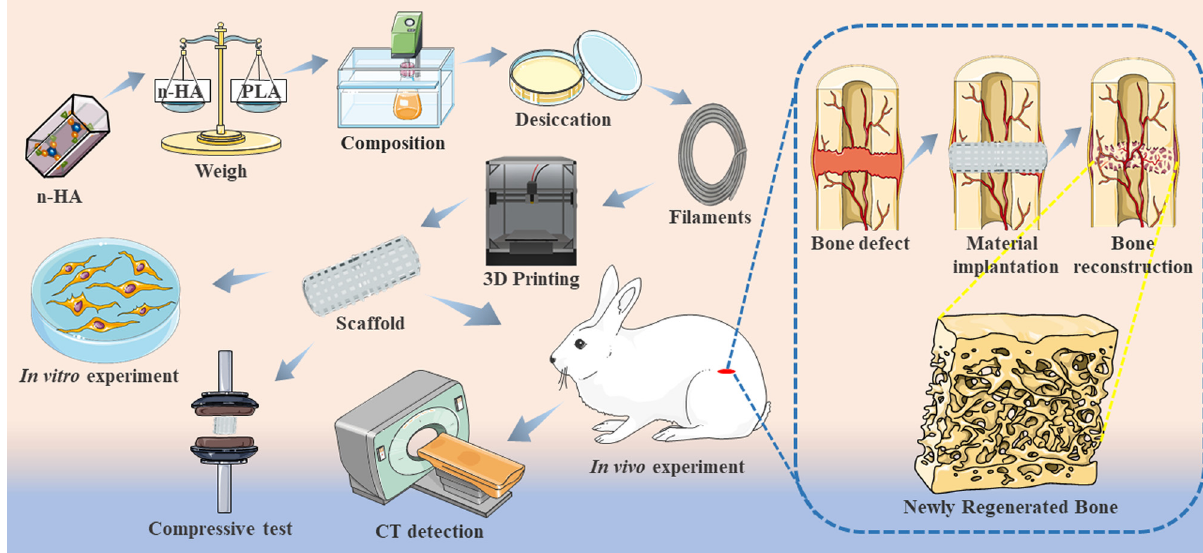
Figure 10: Schematic illustration of the experimental process. PLA and n - HA were uniformly mixed in a 50:50% ratio to make the composite material. Composite sca ff olds were printed for material characterization and in vitro and in vivo